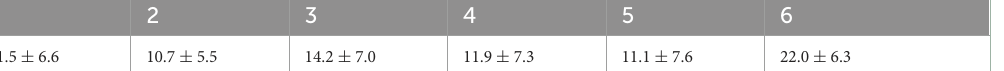
TABLE 4 Information transfer rate (ITR) from the six tests (mean ± standard deviation).